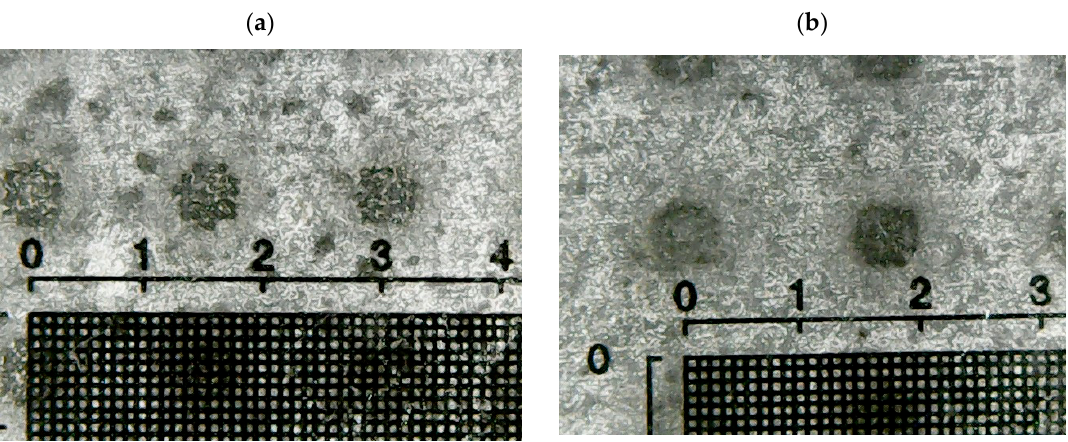
Figure 8. ( a ) Image captured before the forming mechanical process of the metal sheet; and ( b ) image captured after the forming mechanical process of the metal sheet.